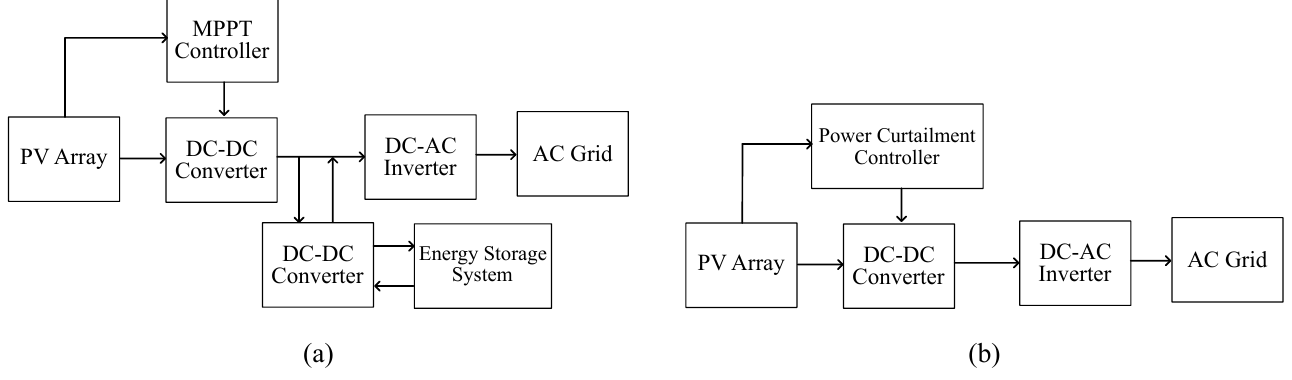
Figure 4. Alternative PV system controls: ( a ) with energy storage system, and ( b ) with power curtailment control algorithm.